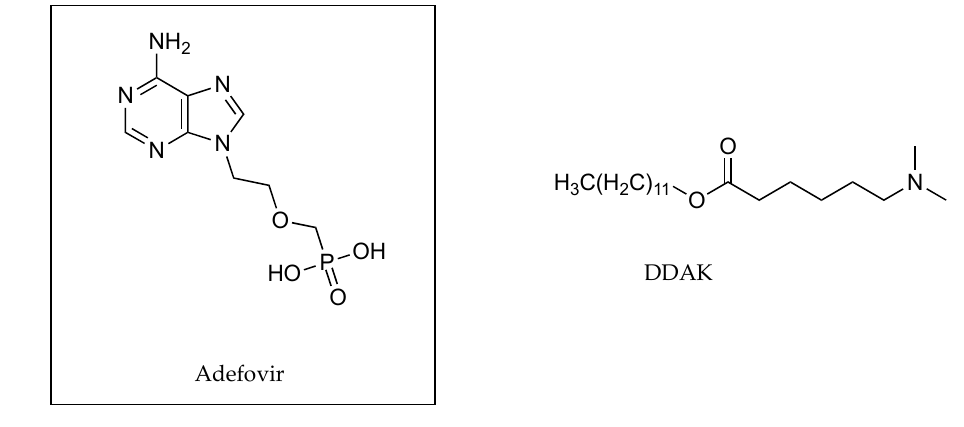
Figure 14. Adefovir and DDAK. Table 16. Flux and skin concentration of 2% adefovir with and without DDAK though porcine skin plotted against pH ( n = 4 for all experiments except pH 5.8 where n = 12, values represent the mean). Adapted from [49], Elsevier,